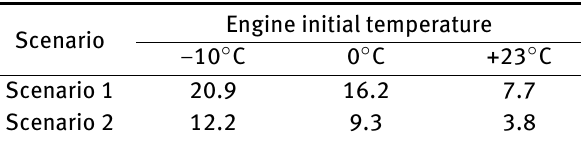
Table 4: Average values of the share of gasoline mass consumption [%] in total fuel consumption for various engine initial